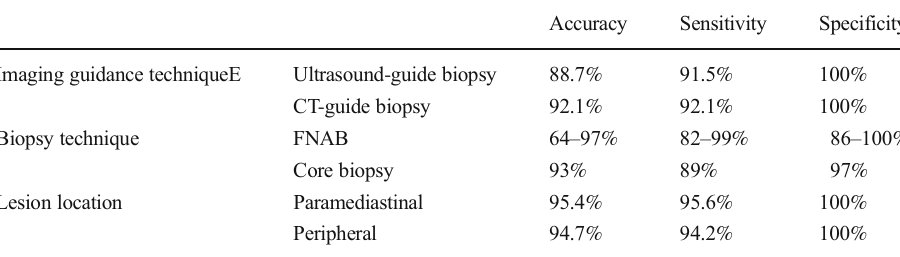
Table 3 Test characteristics for different imaging guidance techniques (ultrasound vs. CT), biopsy techniques (FNAB vs. core biopsy) and lesion location (pamediastinal vs.